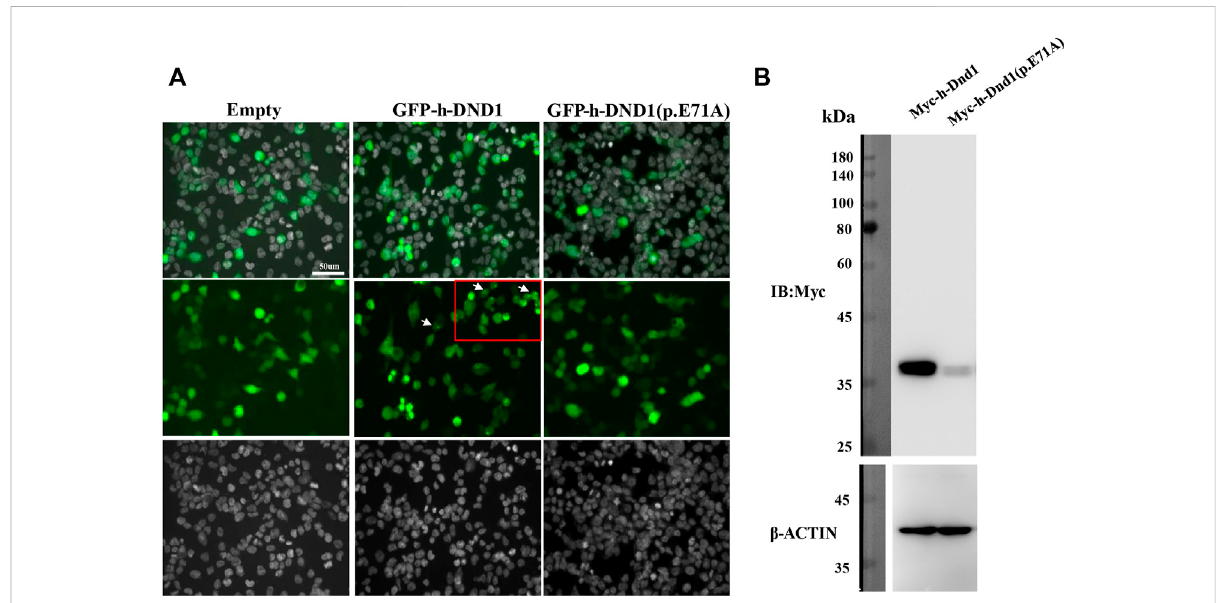
FIGURE 3 E71AmutationaffectedDND1subcellularlocalization andproteinexpression. (A) Heterologous expressionofhumanDND1protein.GFP-fused wild-type and mutated DND1 (E71A) plasmids were transfected into in HEK293T cells. Green, GFP fl uorescence. Cell nuclei were stained with DAPI (gray). Scale bar: 50 µm. (B) The expression levels of wild-type and mutant DND1 protein were detected by immunoblotting with an anti-GFP antibody. ACTIN served as a loading